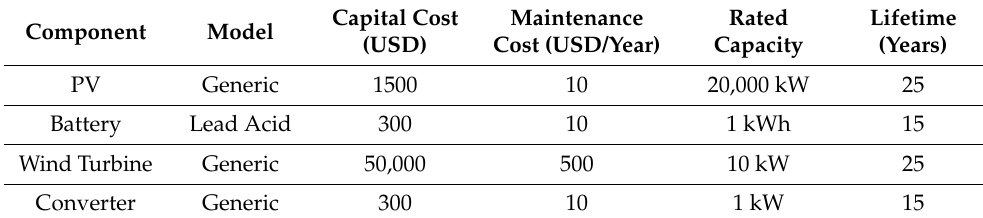
Figure 6. Structure of the proposed hybrid system. Table 3. Characteristics of the components used in the study.